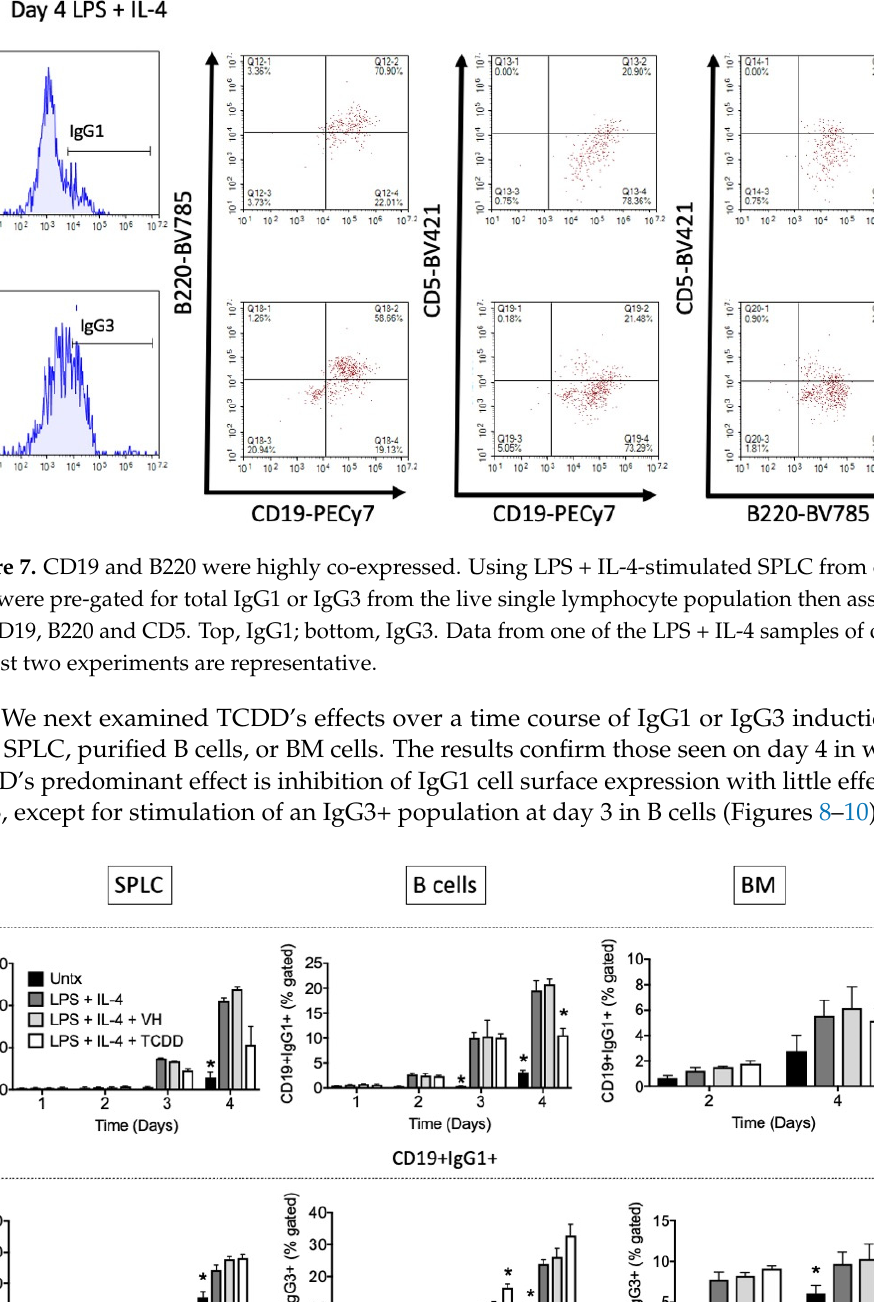
Figure 8. TCDD inhibited the percentage of CD19+IgG1+ cells in B cells at day 4. SPLC, B cells or BM cells were treated with VH (0.01% DMSO) or TCDD (30 nM) for 30 min then were stimulated with LPS + IL-4 (5 µg/mL + 10 ng/mL). Cells were incubated for 1, 2, 3 or 4 days then stained for CD19, B220, CD5 IgG1 and IgG3 (top, IgG1; bottom, IgG3; CD19 shown only). Cells were gated on live single lymphocytes. Bars represent mean ± SD from triplicate samples. Untx, untreated; VH, vehicle. * p < 0.05 as compared to respective LPS + IL-4 + VH control within day. Experiments were repeated at least twice.